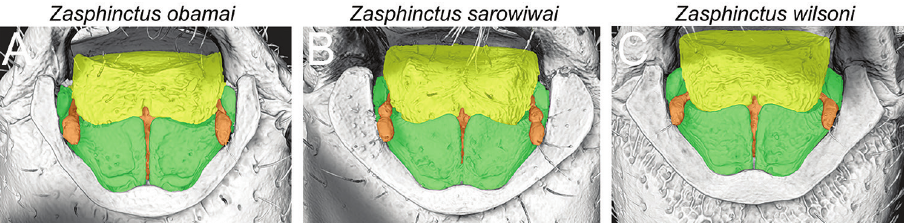
Figure 13. Shaded surface display volume renderings of 3D models of mouthparts (excluding mandi- bles) in closed configuration (green=maxillae; yellow=labrum; orange=labium). A Zasphinctus obamai sp. n. (CASENT0764127) B Zasphinctus sarowiwai sp. n. (CASENT0764654) C Zasphinctus wilsoni sp. n. (MCZ-ENT-00512764).